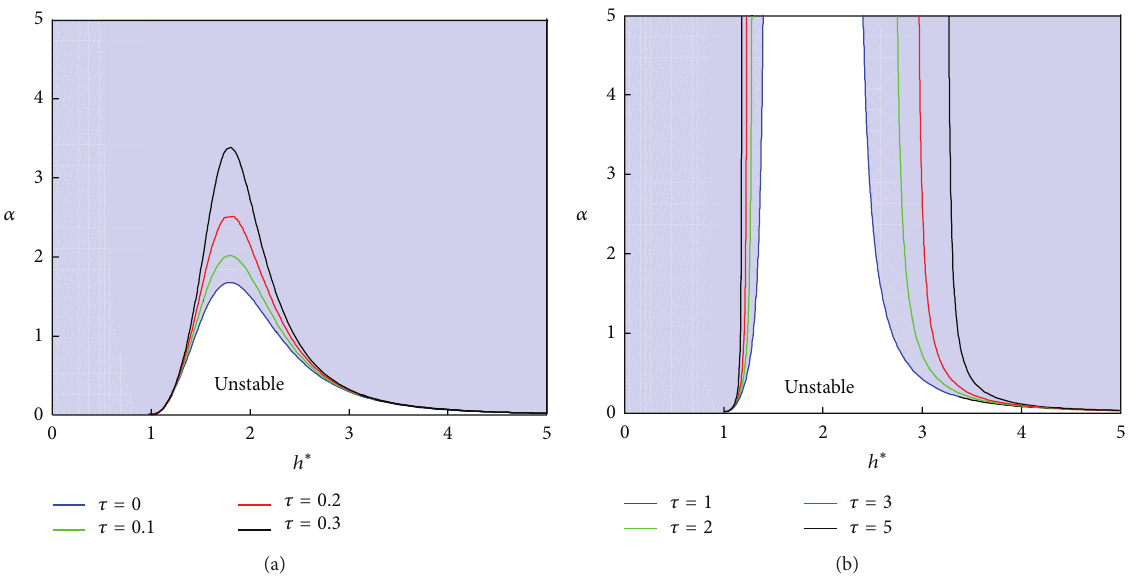
Figure 4: Stability diagram on the (ℎ ∗ ,𝛼) plane on delay impact. (a) 𝜏 = 0, 0.1, 0.2, 0.3 . (b) 𝜏 = 1, 2,3, 5